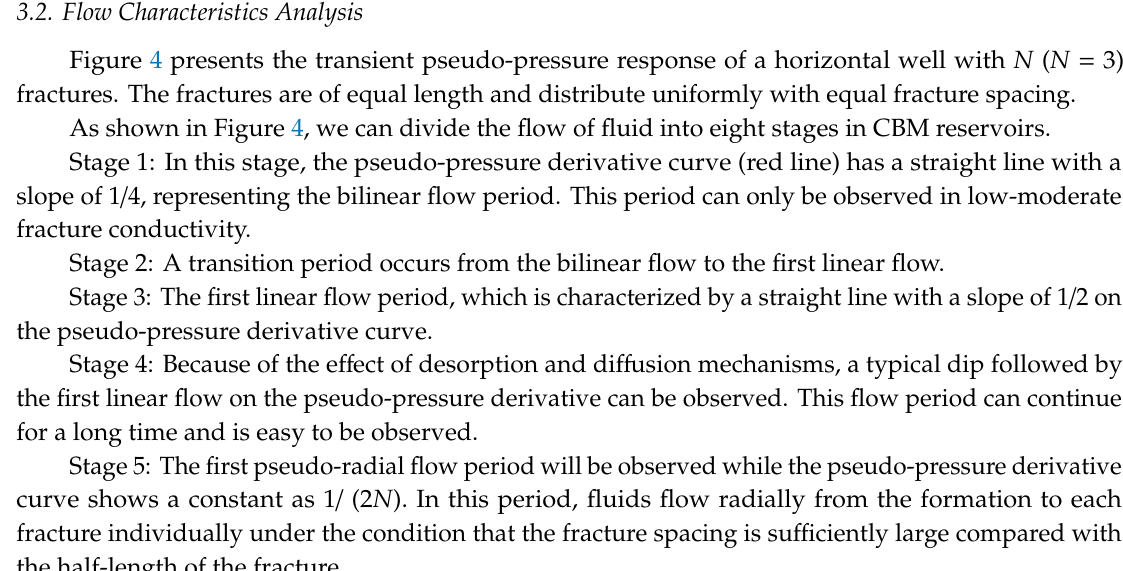
Figure 3. Comparison of our solution for a multi-fractured horizontal well (red circles) with the solution of Zerar (SPE